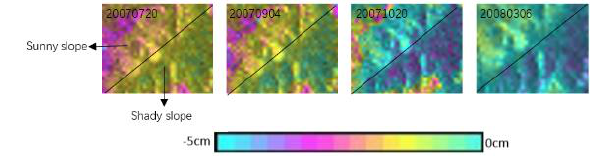
Figure 8. The shady and sunny slope in the study